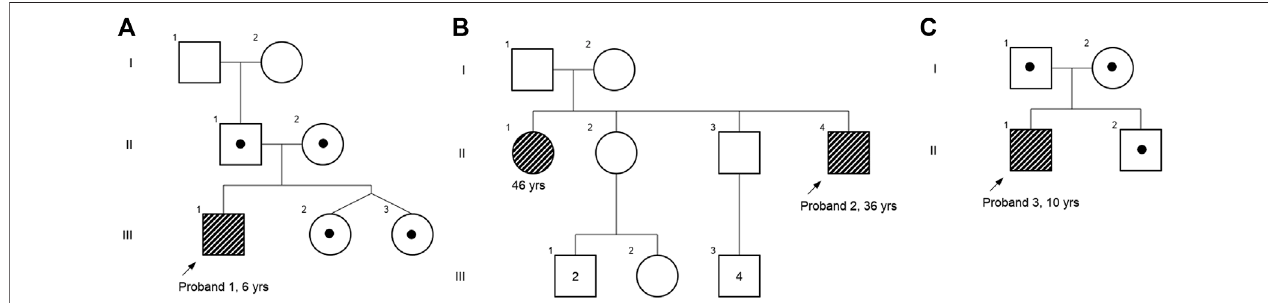
FIGURE 1 | Pedigree chart of ( A ) case 1, ( B ) case 2, and ( C ) case 3. Affected individuals are shaded in gray strips, and carriers are depicted with a